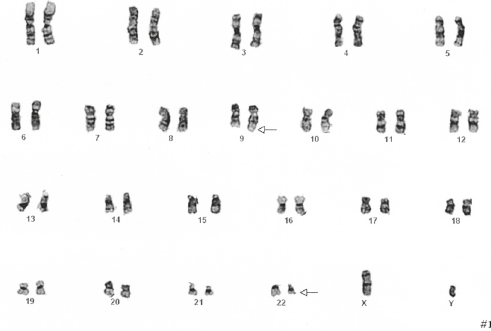
Figure 3: Karyotype analysis obtained from the bone marrow aspirate with the arrow pointing to the t(9;22)